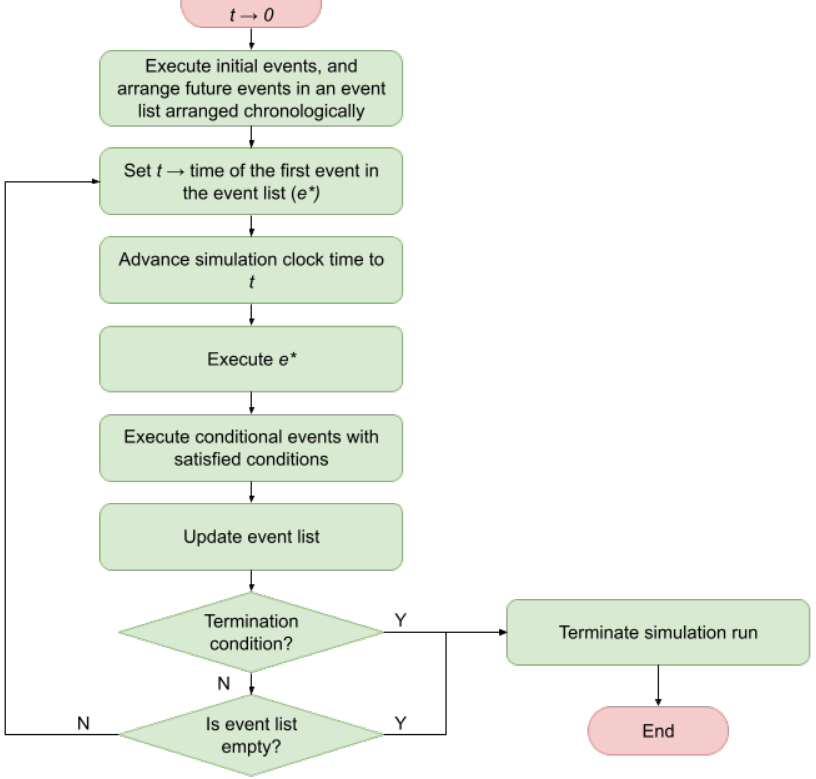
Figure 3. Flow-chart illustrating the discrete event simulation